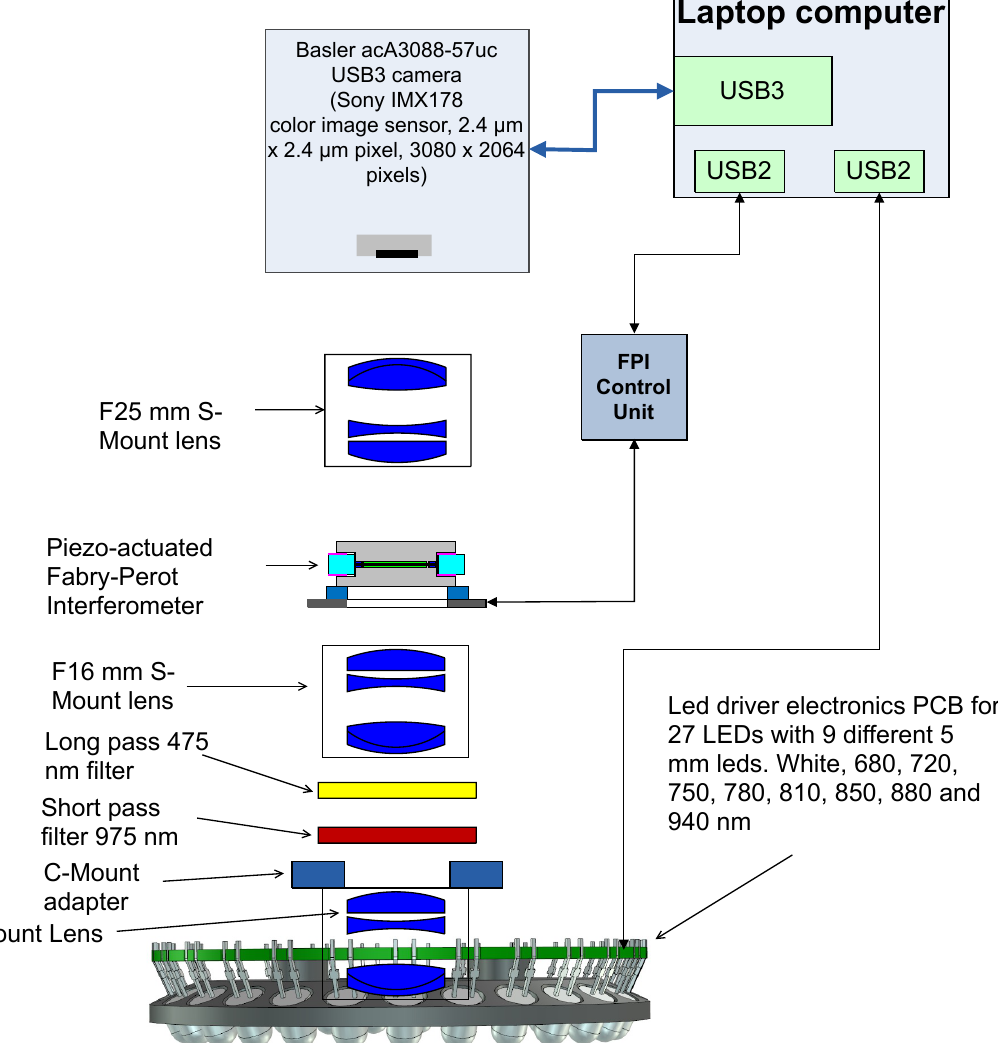
Figure 2. Block diagram of the SICSURFIS spectral imager. Those FPI orders are matched with different sensitivities of the image sensor channels. There are three wavelength channels with different pixels in the RGB sensor’s Bayer pattern. If we carefully select the FPI air gap range, the RGB sensor will receive one to three transmission peaks. After recording the transmission peaks, the different